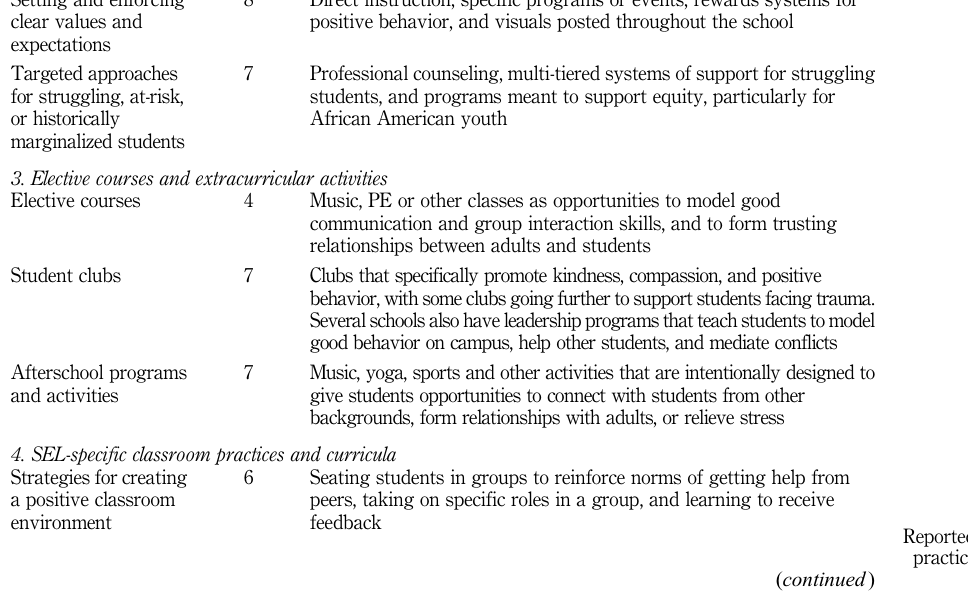
Table III. Reported